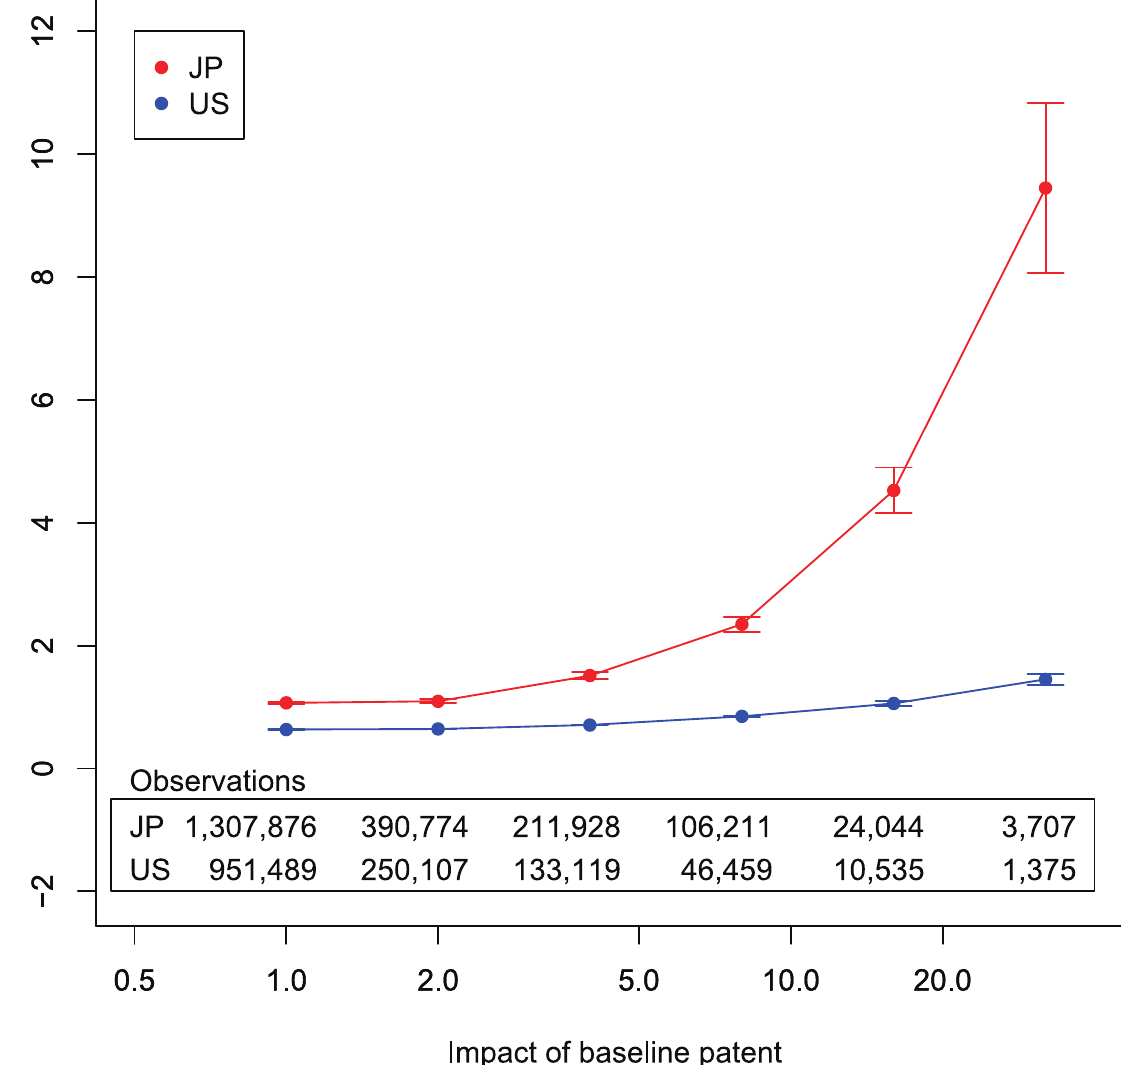
PLOS ONE | DOI:10.1371/journal.pone.0137418 September 4,